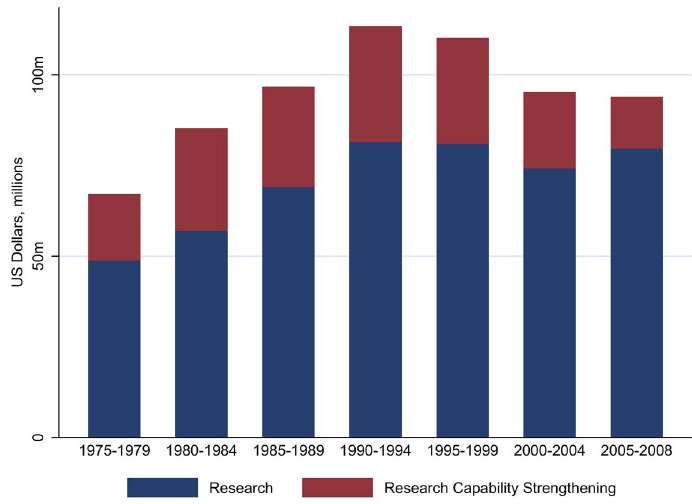
Fig. 1. TDR Research and Research Capacity Strengthening (RCS) funding, 1975–2008.